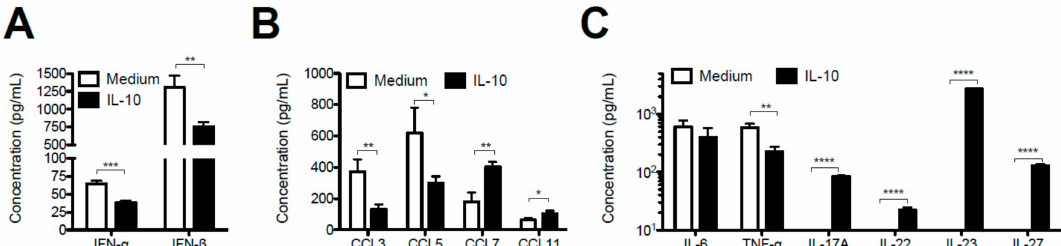
Figure 6. IL-10 altered the response of neonatal AMs to in vitro RSV infection. Neonatal AMs of 6 day-old neonates (pool of n = 50) were infected for 24 h with RSV (5 × 10 4 cells / well, MOI = 5) in the presence of recombinant mouse IL-10 (0.5 mg / mL). ( A ) IFN- α and IFN- β , ( B ) chemokine or ( C ) cytokine productions were measured by luminex assays in cellular supernatants. Results are expressed as mean of triplicate ± SEM (one representative experiment of two). The statistical significance of di ff erences was determined by unpaired t -test (* p < 0.05; ** p < 0.01; *** p < 0.001; **** p <